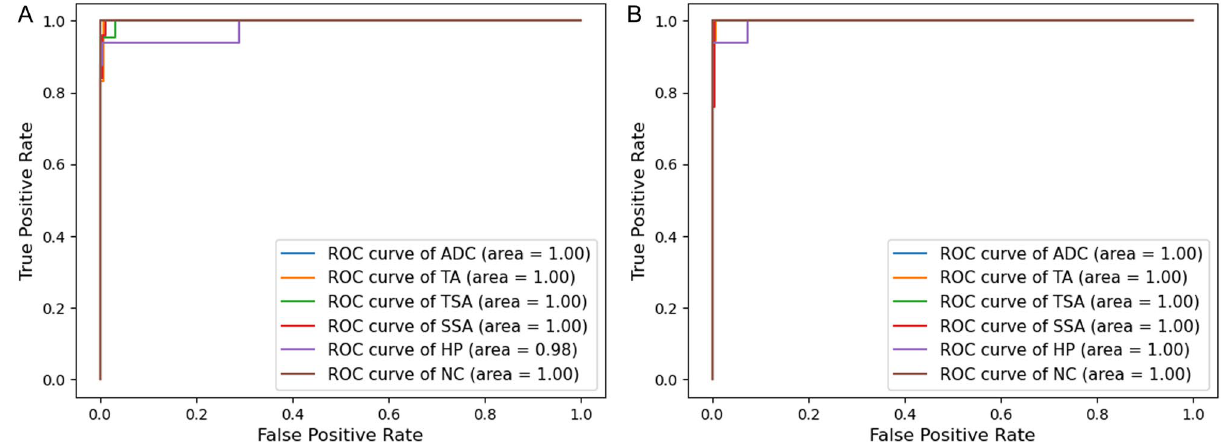
Figure 2. Per-class receiver operating characteristic curves for the best-performing models: ( A ) DenseNet-161 ( B ) EfficientNet-B7.